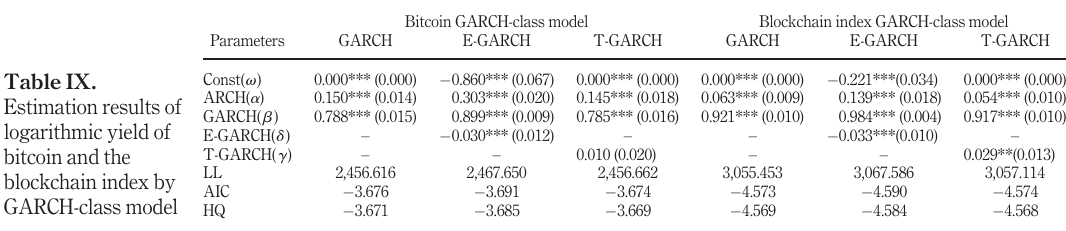
BitcoinGARCH-classmodel